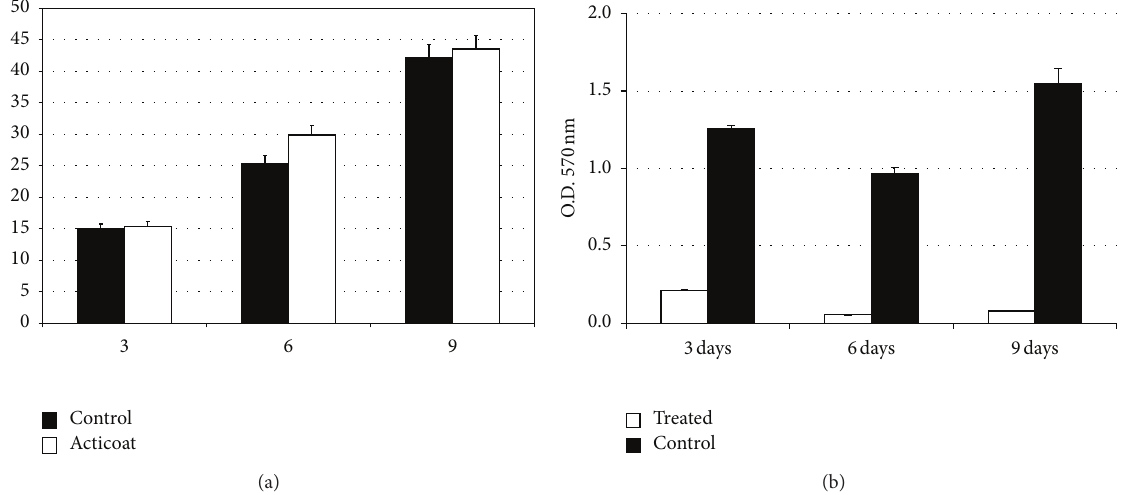
Figure 10: (a) Progression of cell growth in time in a 3D dermal-like tissue after Ag NP streatment (white) and in the control sample (black), mean value ± SD samples versus time. The count of the live cells in the sample is obtained as the sum of the live cells at various depths at each position. (b) MTT test for mitochondrial activity in a 3D dermal-like tissue after Ag NPs treatment (white) and in the control sample (black) mean value ± SD samples versus time. As it is well evident, when silver nanoparticles are present, no mitochondrial activity is